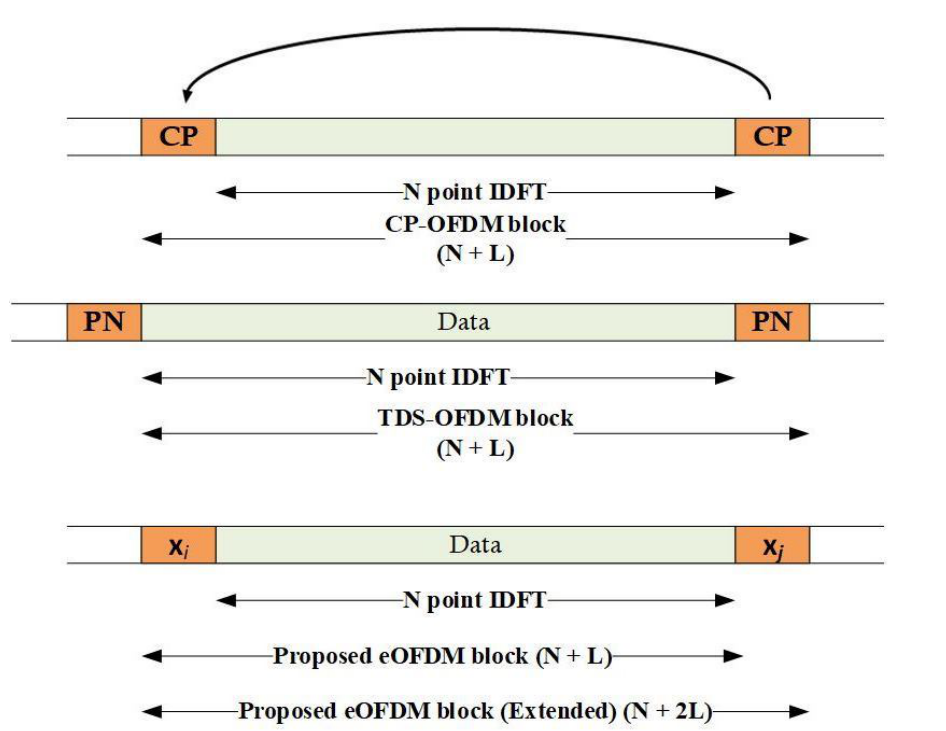
Figure 2. Transmitted blocks of CP-OFDM, TDS-OFDM and eOFDM